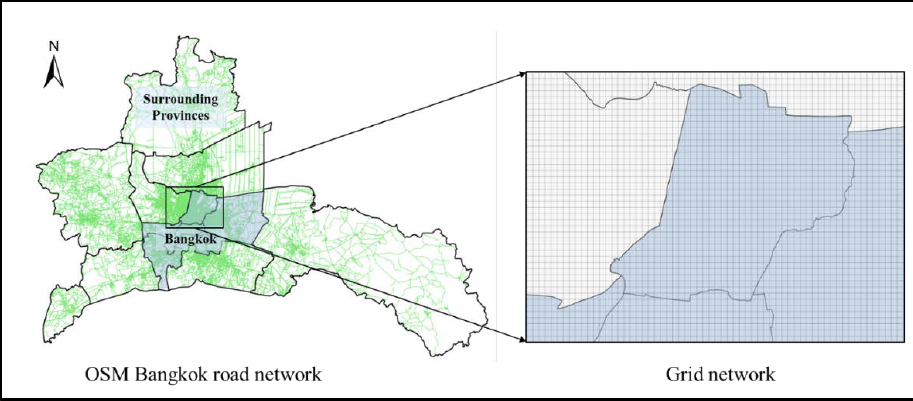
Figure 2. ( Left ) Open Street Map (OSM) Bangkok road network; ( Right ) Grid network.